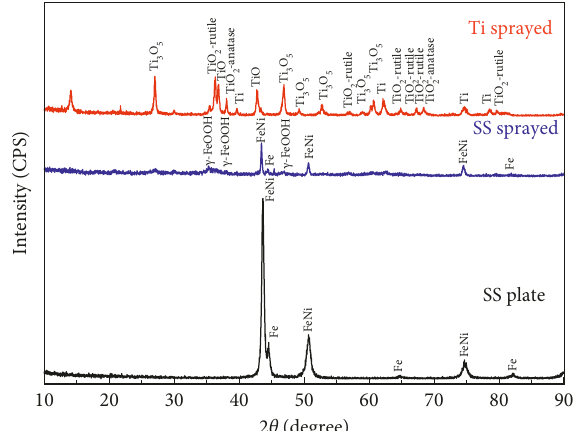
Figure 8: XRD of the SS plate and sprayed coatings after poten- tiodynamic studies in pH 4 solution (0.5 ° /min).